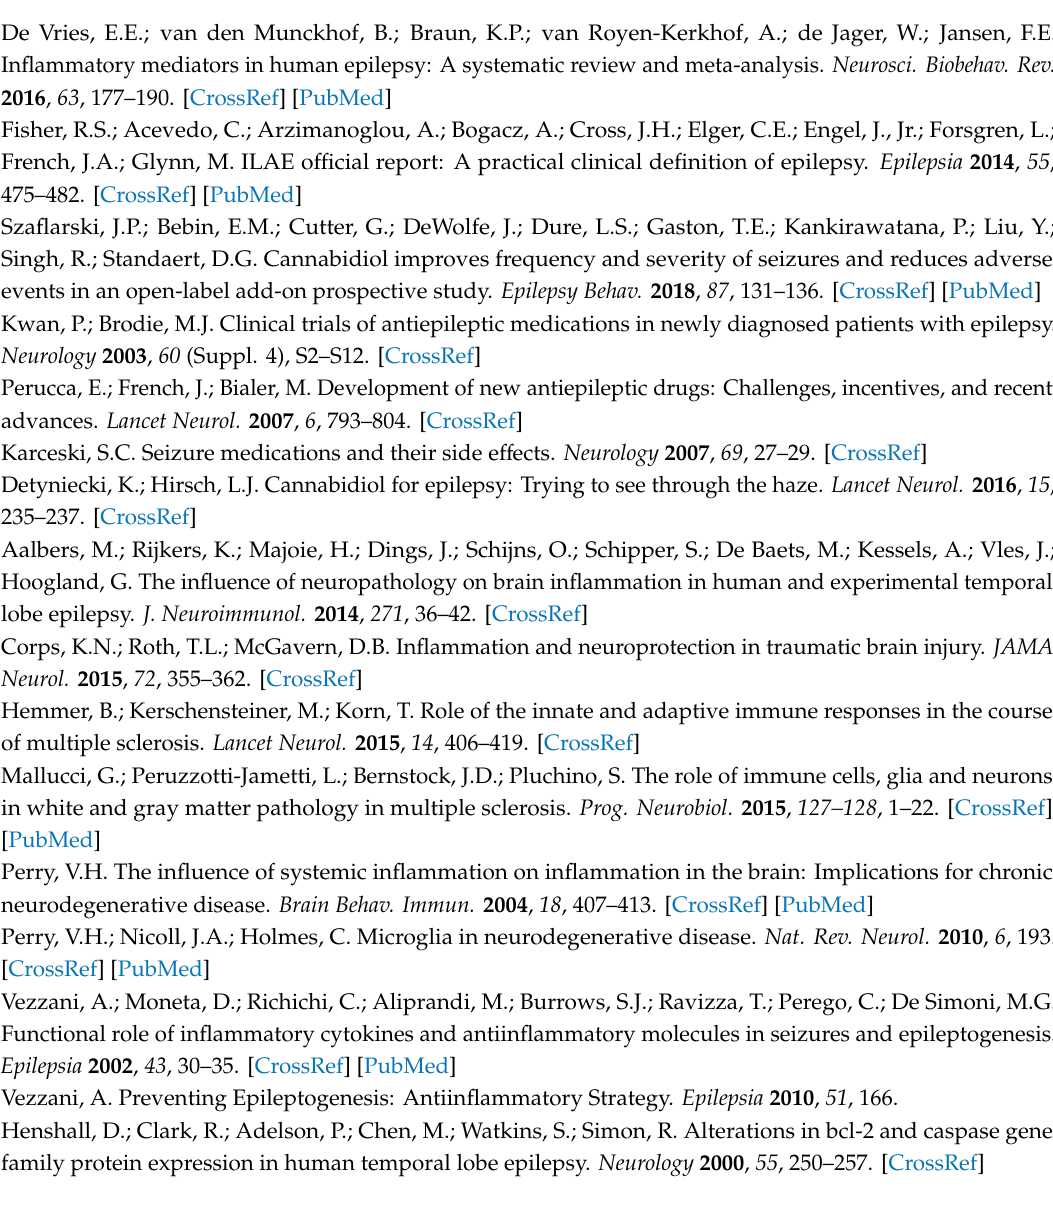
Table S1: Comparison of the mean serum cytokine levels and mRNA gene expression profile among patients on monotherapy (using Na-valproate) ( n = 119) as regard cannabis use, Table S2: Comparison of the mean serum cytokine levels and mRNA gene expression profile among epileptic patients using cannabis “Epilepsy + Cannabis” ( n = 165) as regard AEDs, Table S3: Comparison of the mean serum cytokine levels and mRNA gene expression profile among epileptic patients ( n = 440) as regard sex, Table S4: Comparison of the mean serum cytokine levels and mRNA gene expression profile among epileptic patients using cannabis and on monotherapy ( n = 53) as regard